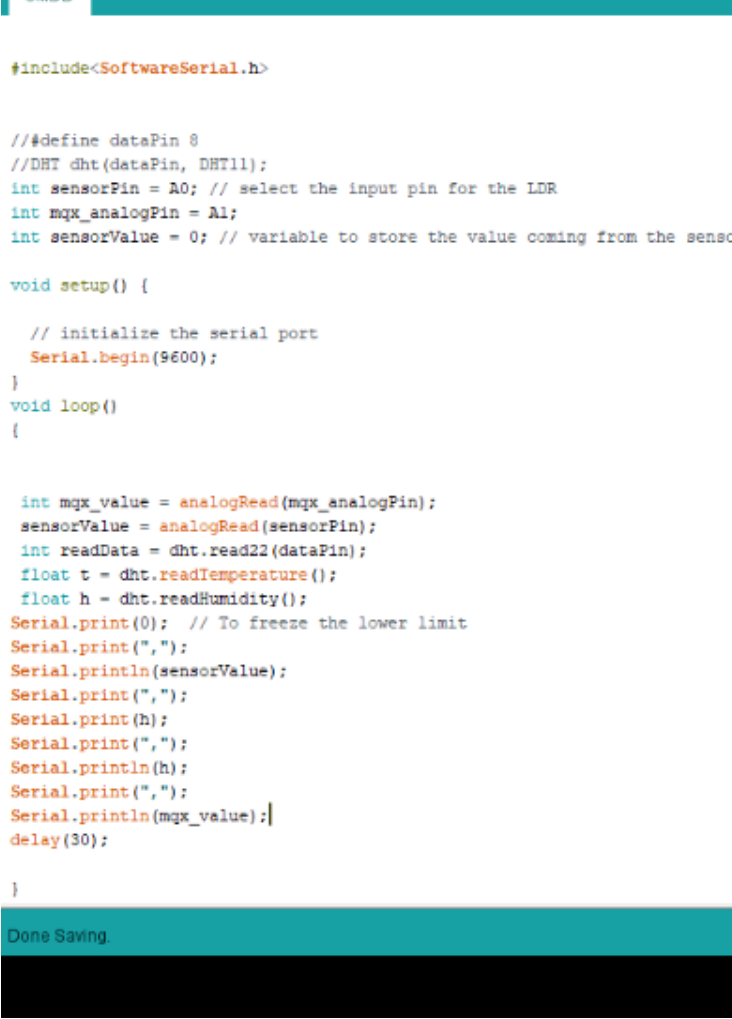
Figure 8. Arduino IDE for serial output of the sensor values.